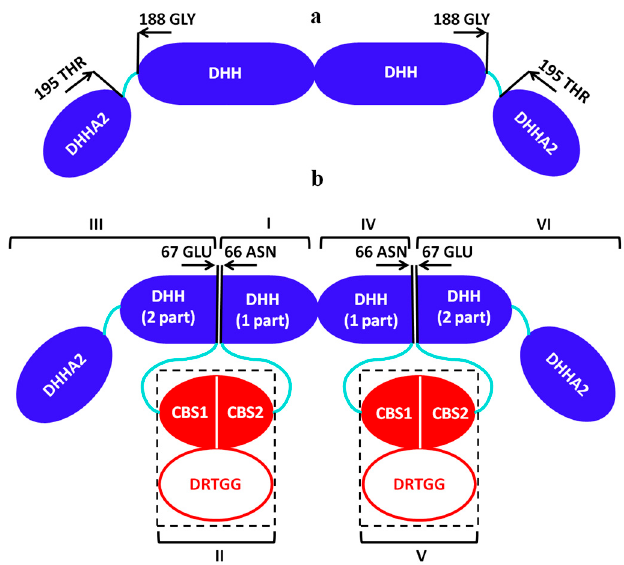
Figure 3. Schematic representation of the domains sequence of dh-PPase ∆ CDC ( a ) and CBS-PPase dimer for the hybrid modeling ( b ). For dh-PPase, I, II (CBS + DRTGG domains), III, IV, and V (CBS + DRTGG domains) were used. For eh- and el-PPase, subunits I, II (only CBS domain), III, IV, V (only CBS domain) were used.